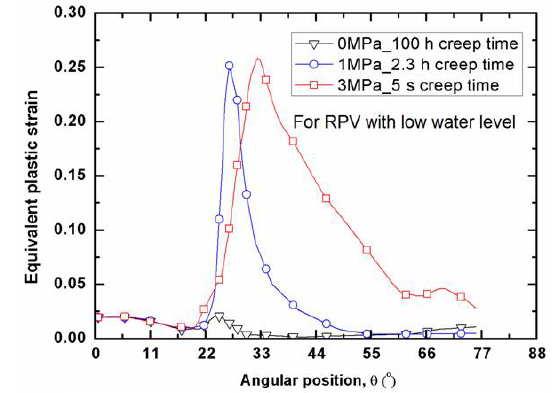
Figure 5. Mises stress distributions across the wall thickness at pre- and post-creep stages.